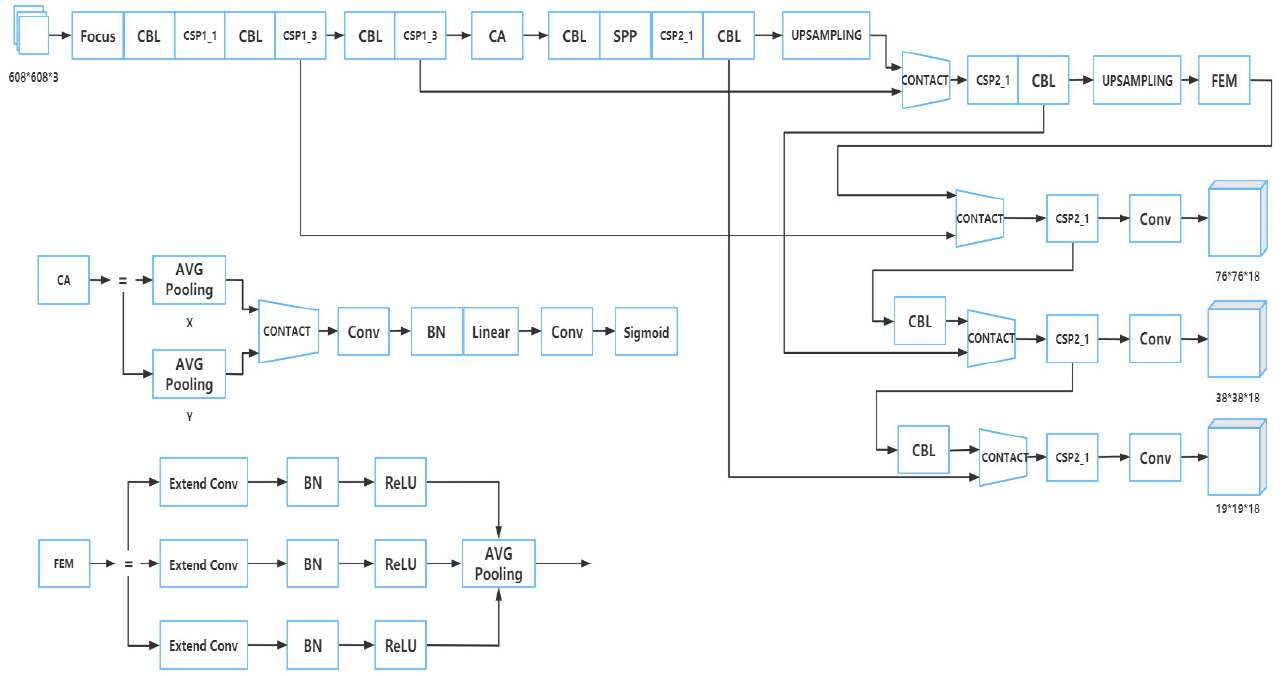
Figure 3. Network structure diagram of Apple-Net.